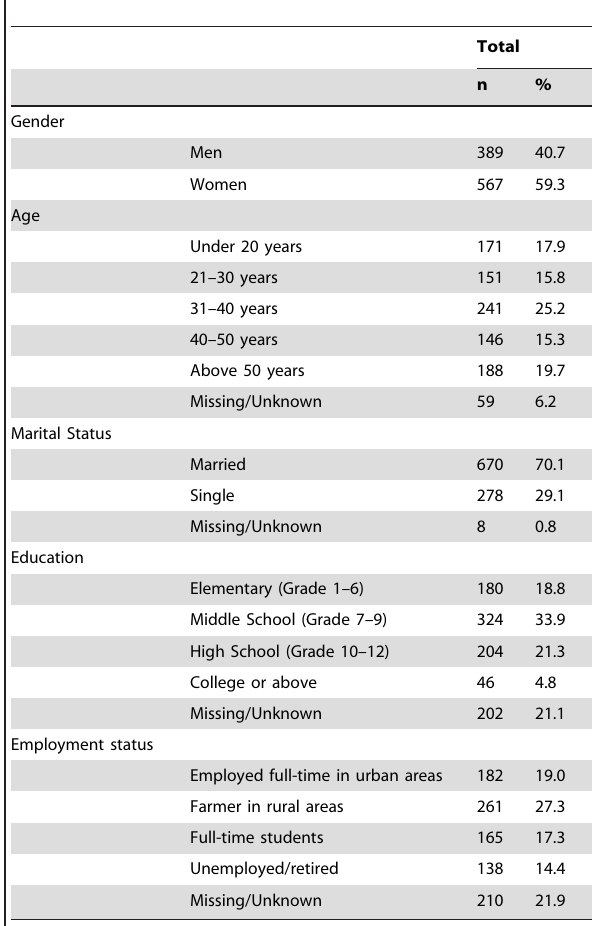
Table 1. Demographic profile of the participants